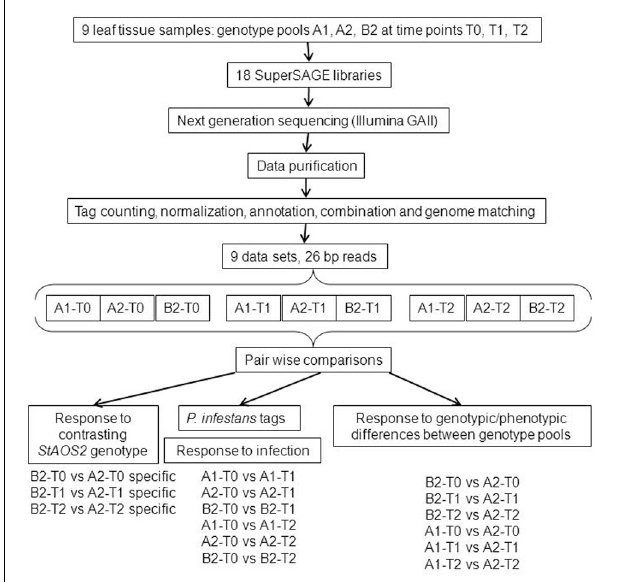
FIGURE 1 | Flow-chart of SuperSAGE experimental design and data analysis. The pair wise comparisons used to select differential transcripts according to different rationales (Results sections P. infestans tags for monitoring infection, Candidate genes for different MCR levels resulting from the contrasting genotype at the StAOS2 locus, Potato transcripts differentially regulated upon infection with compatible P. infestans isolates, and Potato transcripts differential between genotype pool A2 vs. both pools A1 and B2) are shown at the